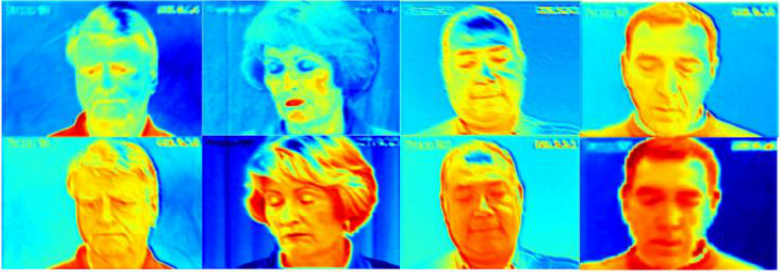
Figure 5. Comparison of the heat map before and after the SA module. The change in color from warm to cold (e.g., red to blue) represents the reduction in attention received during training.